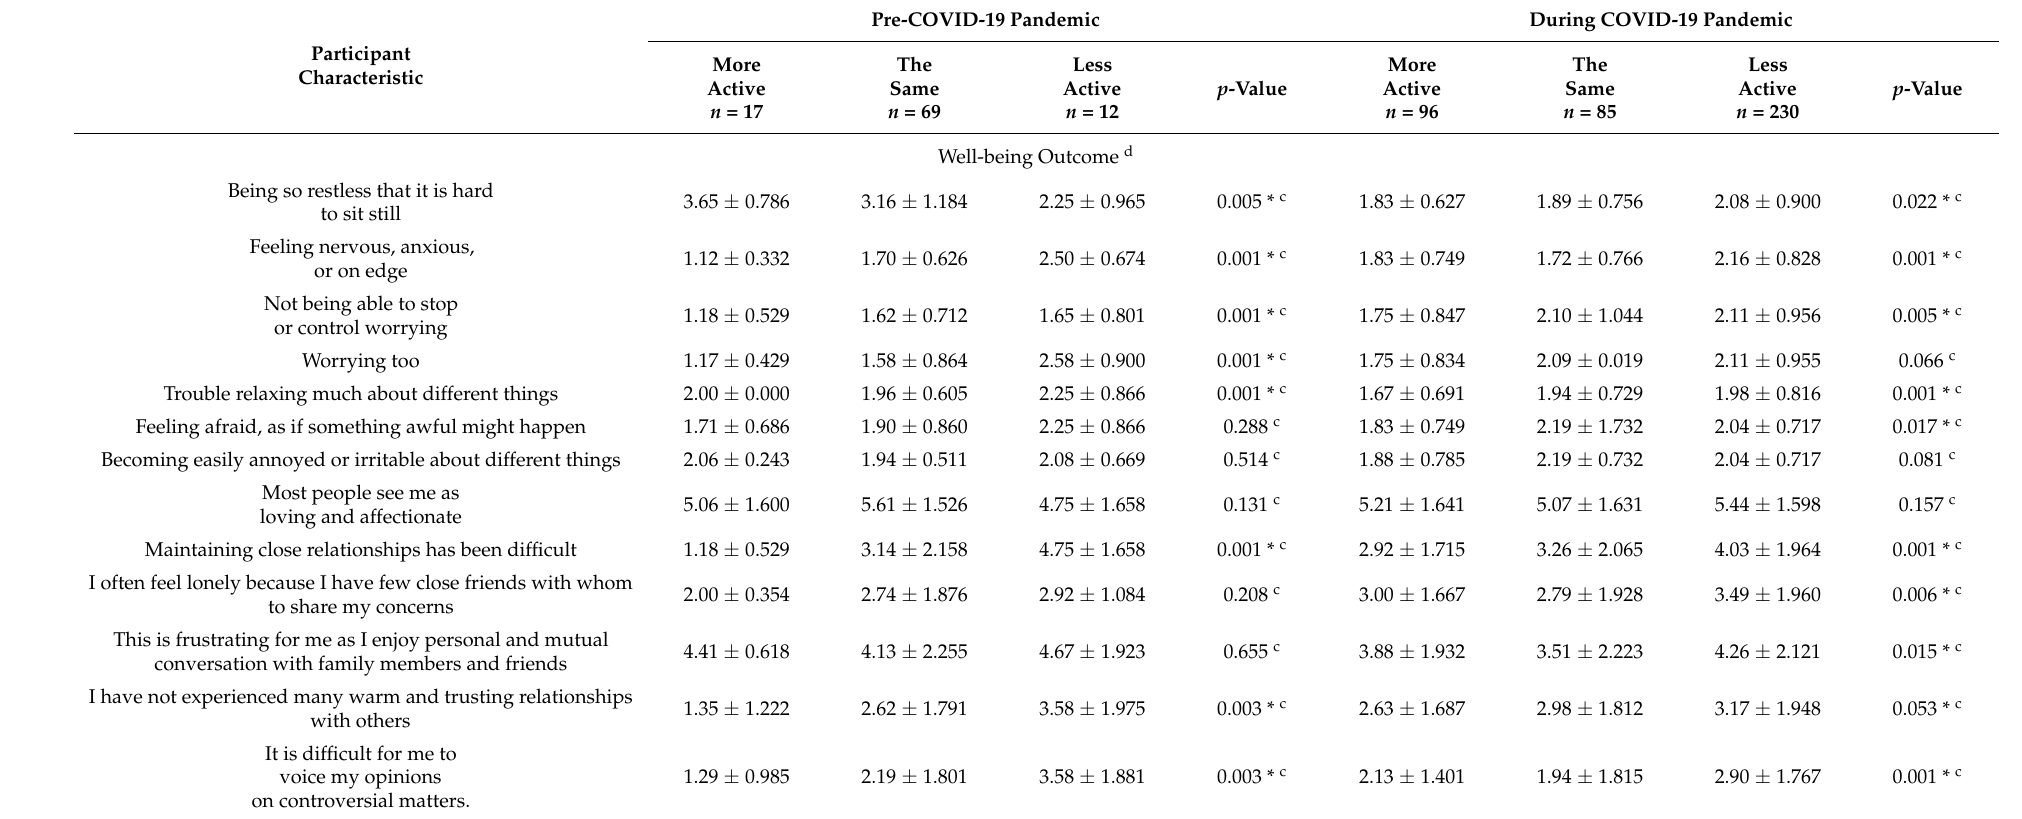
Table 5. The participant’s responses to questions on their well-being during the COVID-19 pandemic. Participant Characteristic